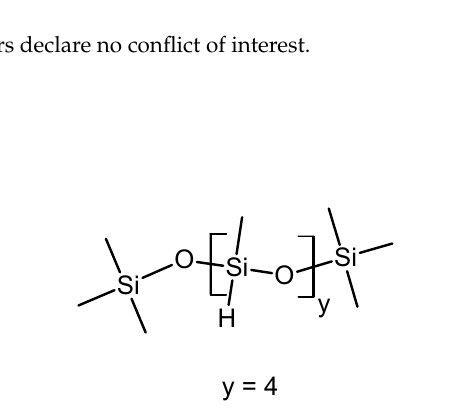
Scheme A1. Structure of poly(methylhydrosiloxane) trimethylsilyl-terminated (PMHS).